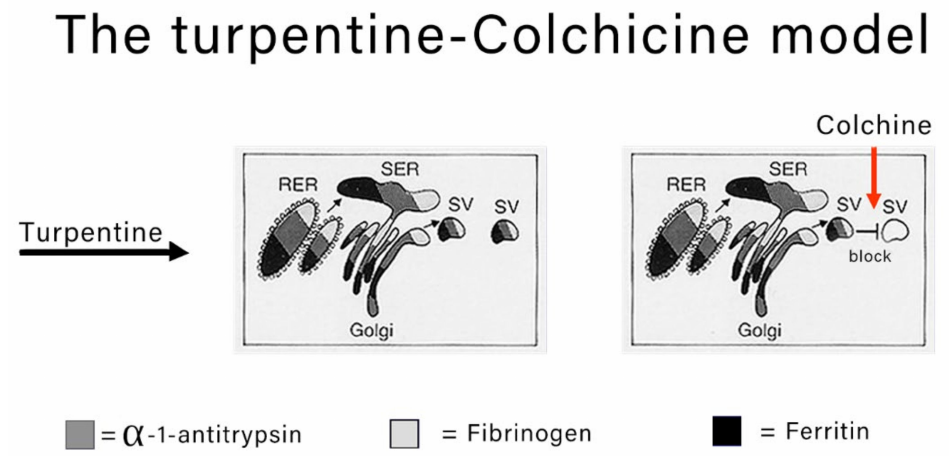
Figure 2. Schematic representation of stimulation and block of secretion in animal models. Turpentine stimulates the liver to increase the synthesis of acute phase reactants (AAT, fibrinogen, ferritin). The proteins translocate from the RER to the SER, Golgi apparatus and SV. The injection of colchicine blocks the migration of SV towards the plasma membrane hampering the export. That results in a collective retention of the proteins within the entire